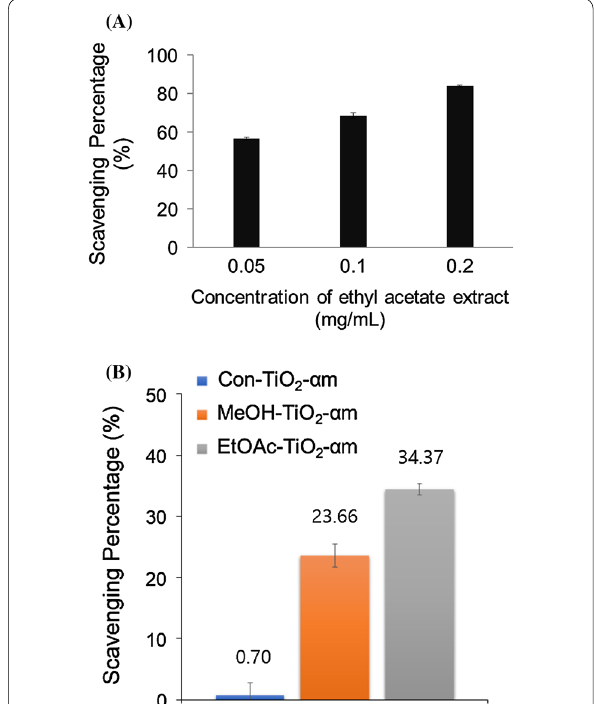
Fig. 6 DPPH radical scavenging activity. a Ethyl acetate extract and b the functionalized TiO 2 NPs (EtOAc‑TiO 2 ‑αm, MeOH‑TiO 2 ‑αm and Con‑TiO 2